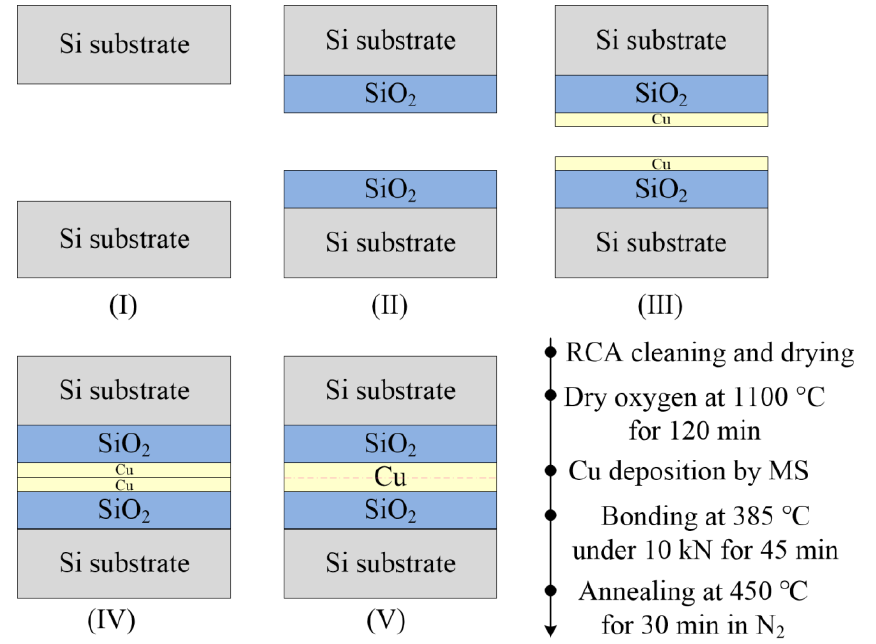
Figure 11. Process flow for fabrication of the stacked bonding structure.